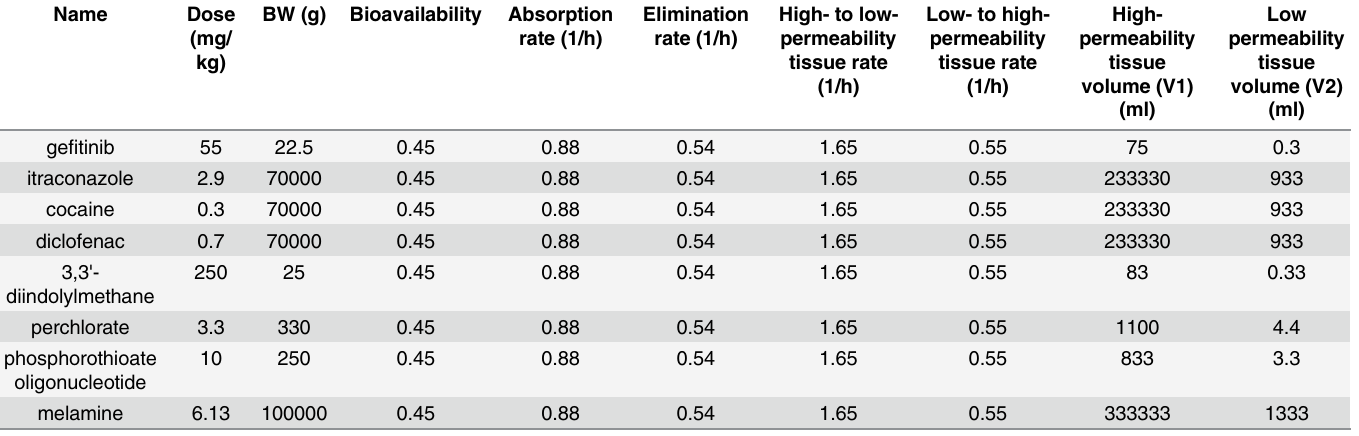
Table 4. Model parameters for selected gefitinib ’ s close-analogues and non-analogues.